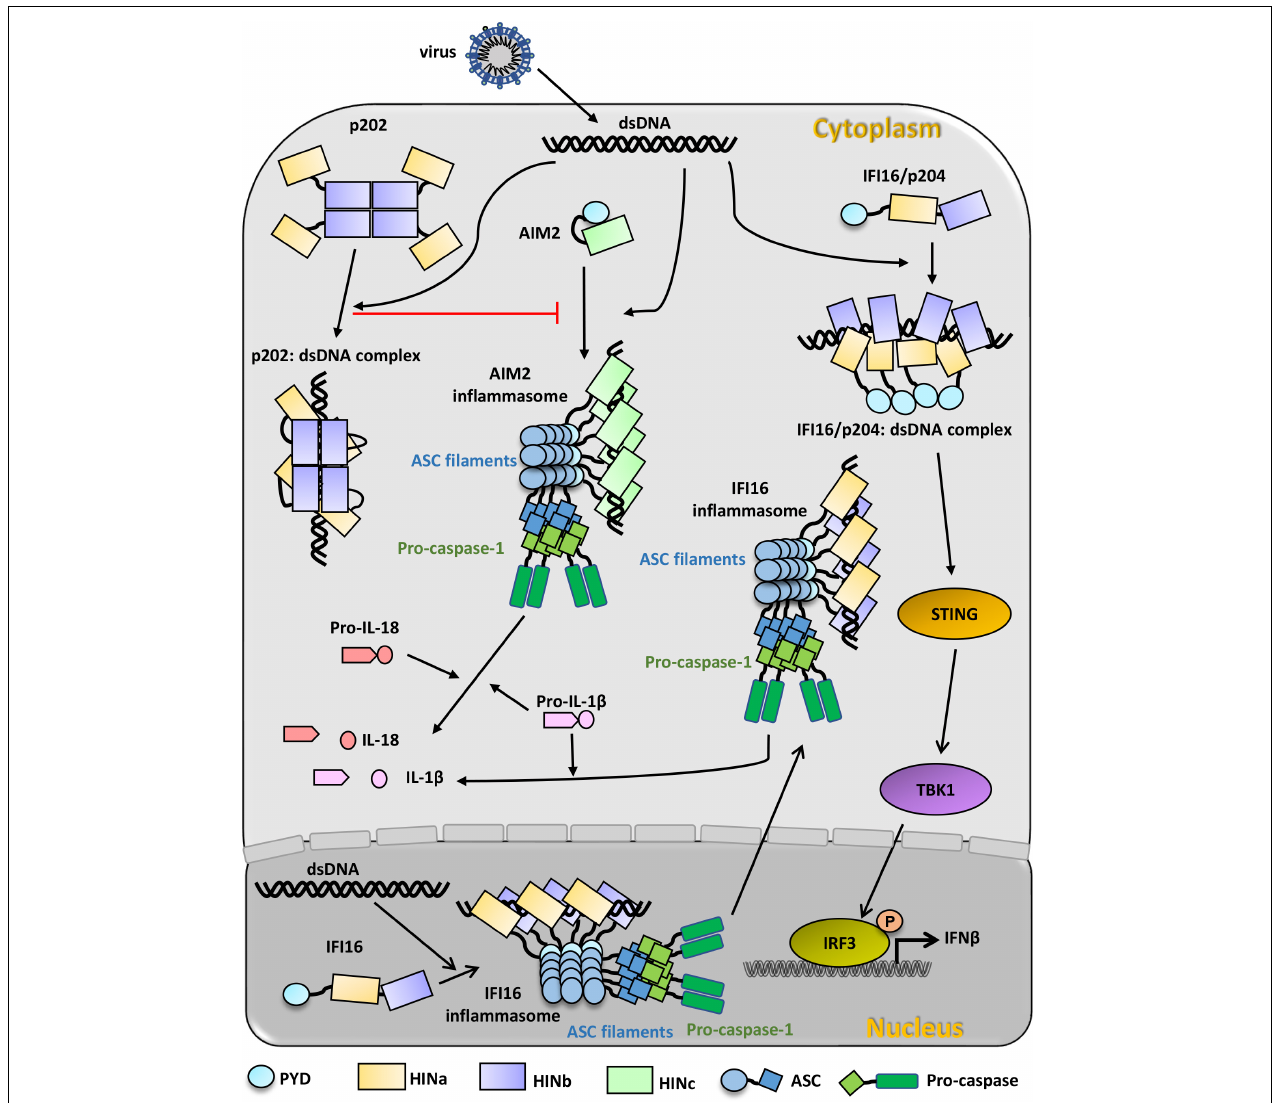
FIGURE 3 | PYHIN family proteins in innate immunity recognition of viral dsDNA. Cytosolic dsDNA from invading virus activates AIM2, which presents an auto-inhibition state before recognizing viral dsDNA. AIM2 HIN domain binds to dsDNA in the cytosol and subsequently binds to the adapter ASC through PYD: PYD interaction. AIM2 inflammasome is formed through AIM2-ASC-procaspase-1 oligomerization. Activated caspase-1 can directly cleave pro-IL-1 β and pro-IL-18 to IL-1 β and IL-18, which can respond to infection. p202 exists as a tetramer in the cytosol and can also bind to dsDNA from invading viruses. p202 can inhibit the formation of AIM2 inflammasome. IFI16 presents an extended state before recognizing dsDNA. In the nucleus, viral dsDNA binds to IFI16 HIN domains and induces IFI16 oligomerization with the assistant of ASC and pro-caspase-1, and the oligomer migrates to the cytoplasm to cleave pro-IL-1 β to IL-1 β . In the cytosol, viral dsDNA can also directly initiate the activation of IFI16/p204 independent of the inflammasome. Multiple IFI16/p204 HINab domains synergistically bind to the long dsDNA, resulting in the adjacent PYD aggregate to activate STING and TBK1. Activated TBK1 phosphorylates IRF3 and induces the production of IFN β to defend against the virus